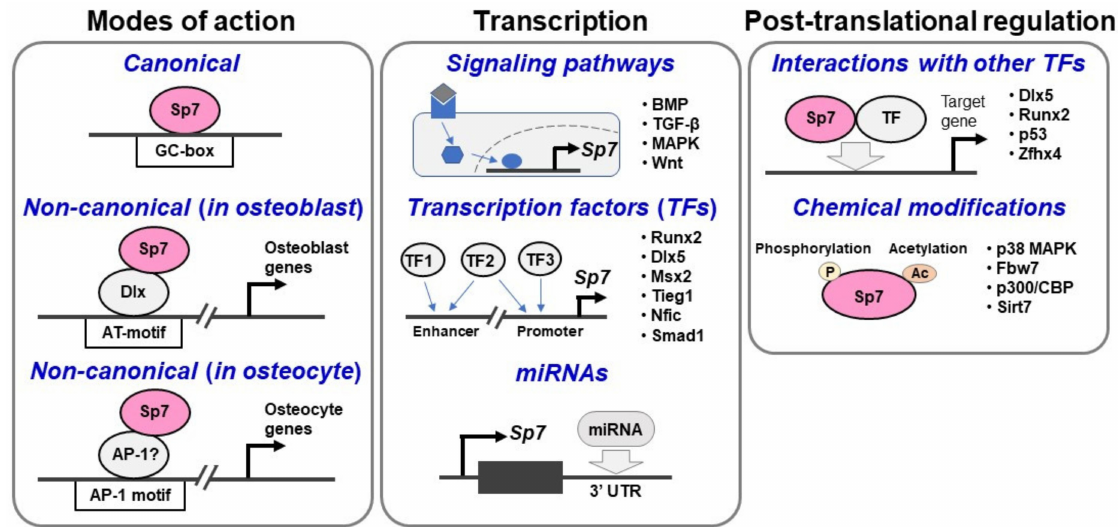
Figure 1. Current understanding of Sp7 actions and regulations. Modes of Sp7 action ( left ), tran- scriptional regulations of Sp7 ( middle ), and post-translational regulations of Sp7 ( right ) activities are